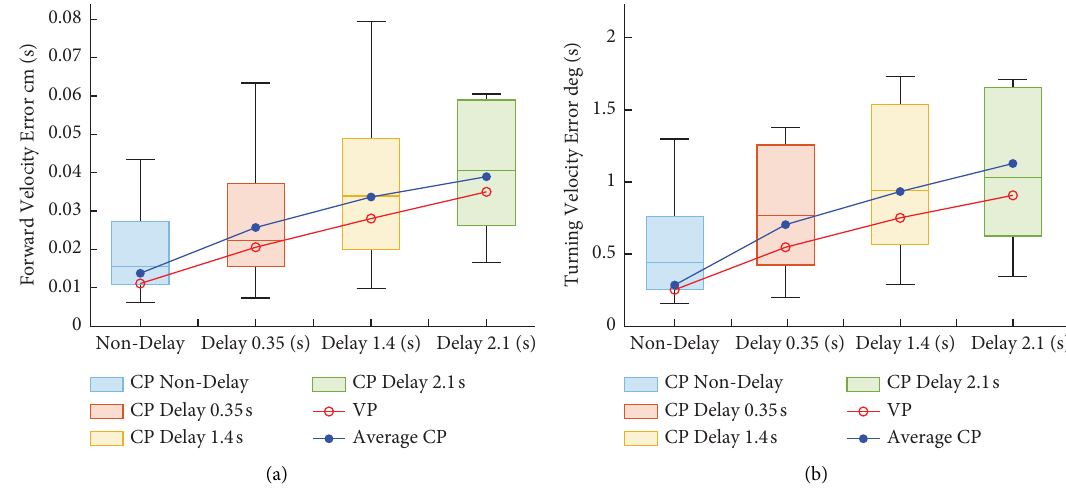
Figure 8: Coordination errors of the teleoperation system (a) for forward speed and (b) for turn